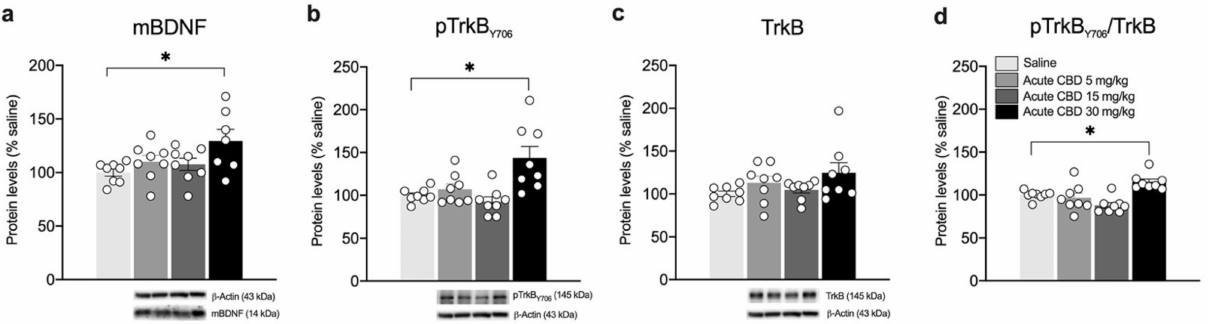
Figure 4. Effects of acute CBD exposure on mBDNF and TrkB receptor protein levels in the mPFC. Rats were treated with a single injection of CBD 5 mg/kg, 15 mg/kg, or 30 mg/kg and killed one hour after treatment. Protein levels of BDNF ( a ), phospho(p)-TrkBY706 ( b ), TrkB ( c ), and of the ratio pTrkB/TrkB ( d ) measured in the homogenate of mPFC are expressed as percentages of